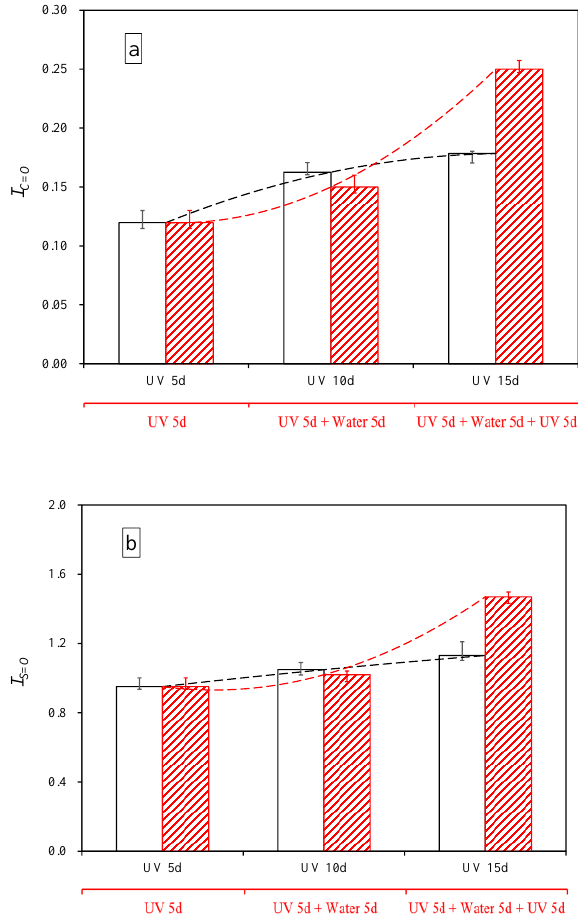
Figure 11. I C=O and I S=O of asphalt after the aging cycle of UV and water. ( a ) I C=O , ( b ) I S=O .